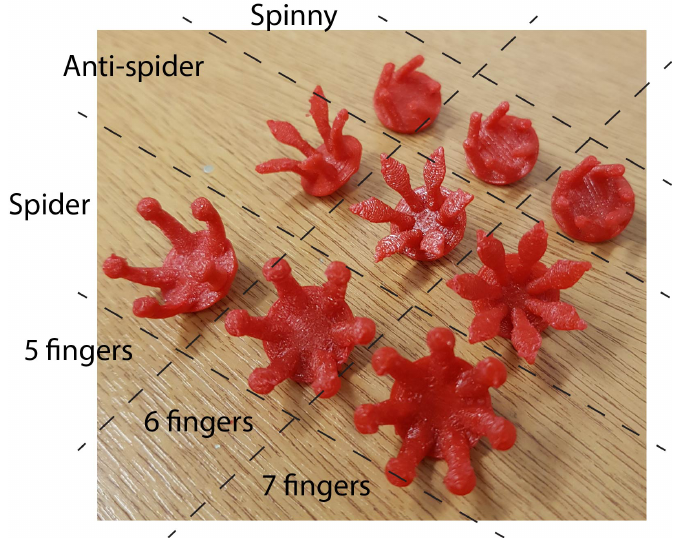
Figure 4. Nine different electrode configurations investigated here after 3D